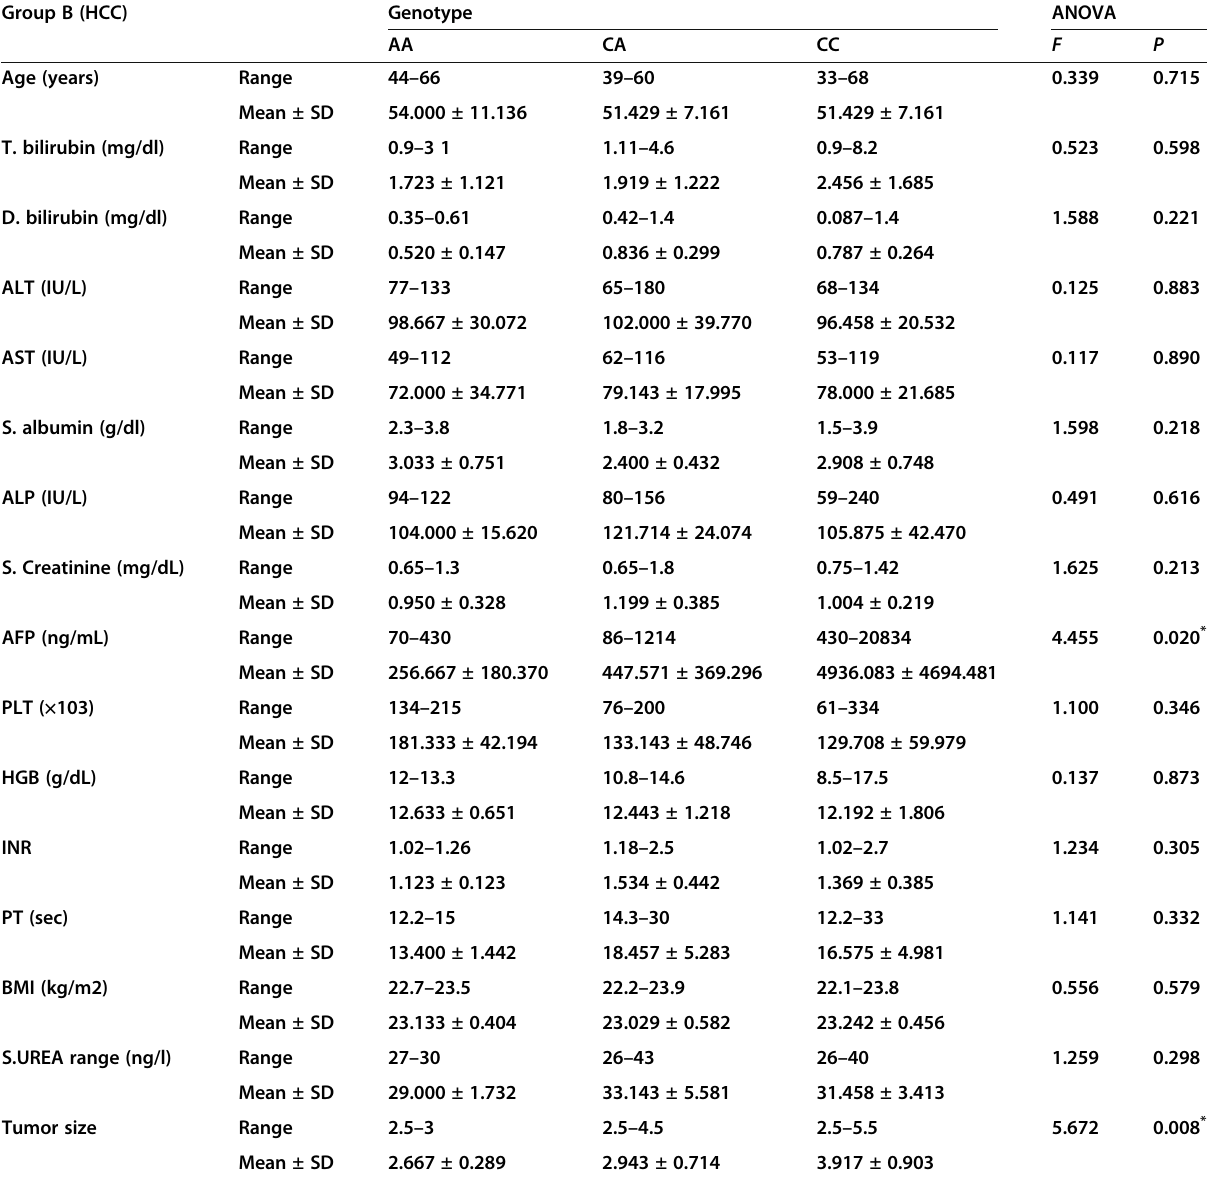
Table 4 Relation between Apa-1vitamin D receptor genotypes and different parameters in the hepatocellular carcinoma (HCC)